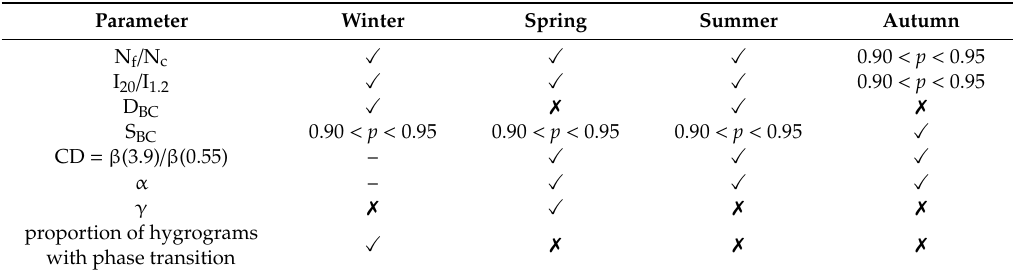
Table 1. Estimation of significance of differences between the aerosol weather types Background and Haze-S.